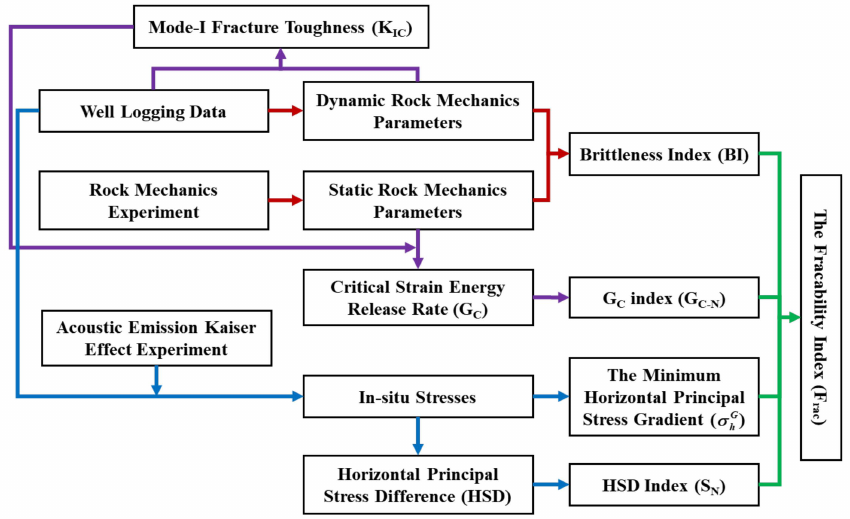
Figure 4. Flow chart of the calculation of each parameter in the fracability index ( F rac )